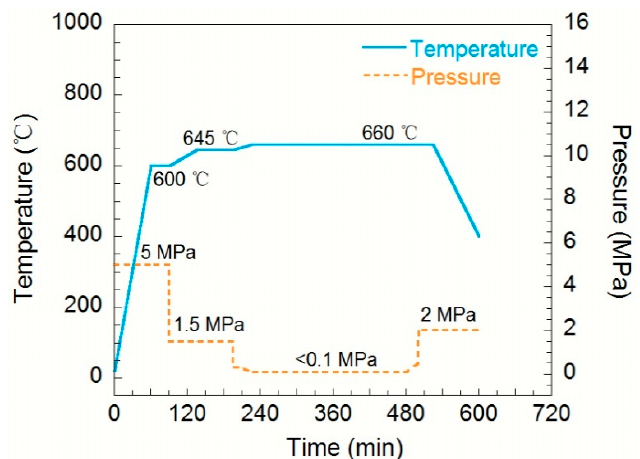
Figure 2. Processing parameters for fabricating the Ti-(SiC f /Al 3 Ti)-laminated composite via vacuum hot pressing.